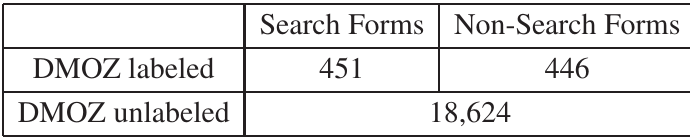
Table 1. Dataset used in the